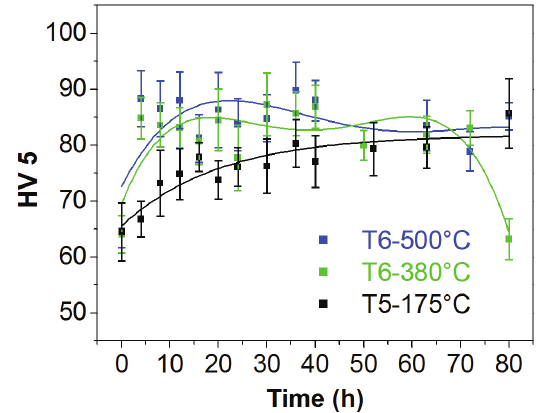
Figure 5. Hardness (HV5) as a function of heat treatment time for the ZK60-1.5wt.%RE alloy submitted to ageing treatment at various temperatures.